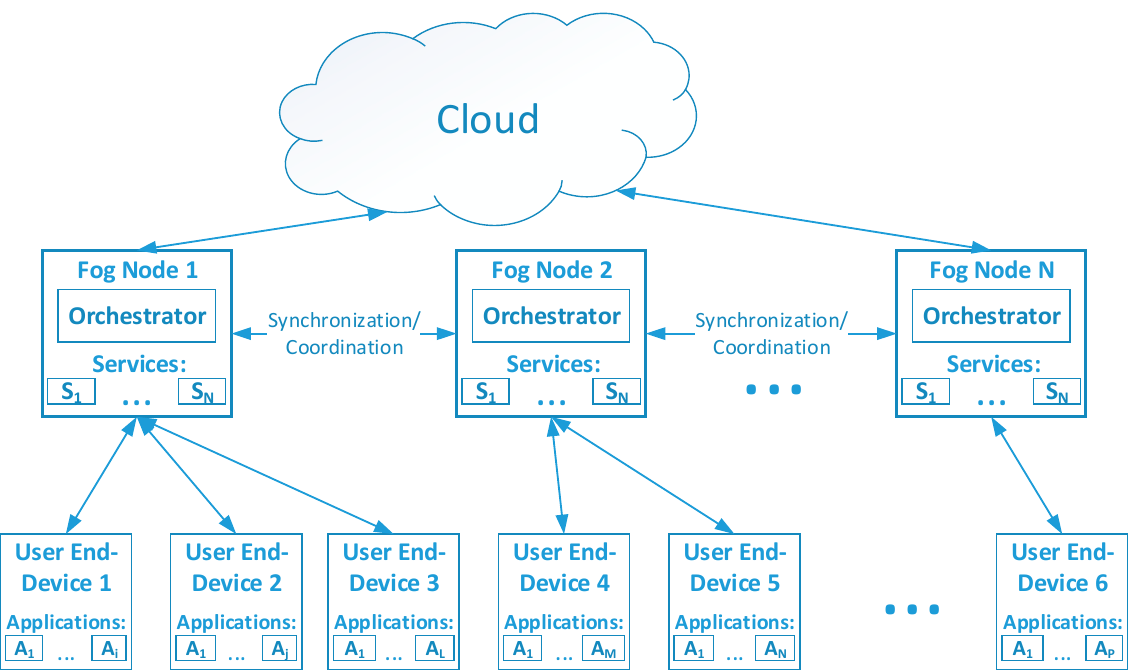
Figure 2. Model of the proposed distributed orchestrator architecture.